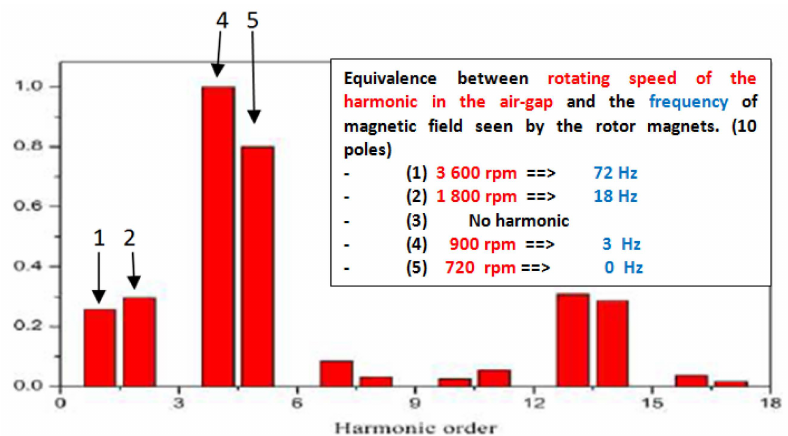
Figure 16. The amplitudes of magnetic field harmonics in the air-gap selected by rank in a 9-slot structure. The two main harmonics (four and five) can provide an 8-pole machine or a 10-pole machine. For a 10-pole machine, the harmonics of magnetic fields generate variable magnetic fields for the rotor. Their frequencies, for an observer link to the rotor are given in the upper part of the figure (10-pole). Notice the null frequency for the harmonic five, the rotor is synchronized with